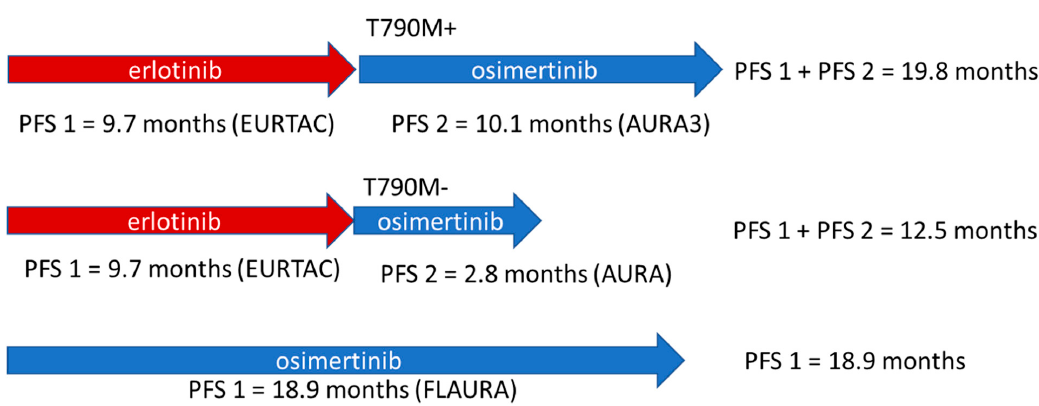
Figure 1. Theoretical comparison of the overall duration of response with two different sequencing paradigms. Pictured above is the sequencing strategy in which an earlier-generation EGFR TKI, erlotinib, is used in the first line, followed by the later-generation EGFR TKI osimertinib after progression in the setting of acquired T790M mutation. Progression-free survival (PFS) for first-line erlotinib is drawn from the phase 3 EURTAC trial, which compared erlotinib to conventional chemotherapy in the first-line setting [15]. The median PFS for osimertinib after progression on early-generation EGFR TKIs in T790M-positive patients was derived from the AURA3 trial [55]. The median PFS for osimertinib after progression on EGFR TKIs in T790M-negative patients was derived from the AURA trial [60]. Pictured below is the sequencing strategy in which the later-generation TKI was used in as a first-line treatment based on the PFS demonstrated in the FLAURA trial [29]. In this comparison, sequential therapy with the earlier-generation EGFR TKI followed by the later-generation TKI after progression with T790M-positivity yielded a greater overall duration of response than the use of later-generation EGFR TKI as the first-line treatment. Fully acknowledging the limitations of the cross-trial comparison, this nonetheless illustrates that the superior efficacy of later-generation therapies in the front line may not lead to superior overall survival despite a clearly superior PFS when comparing front-line therapies in isolation.